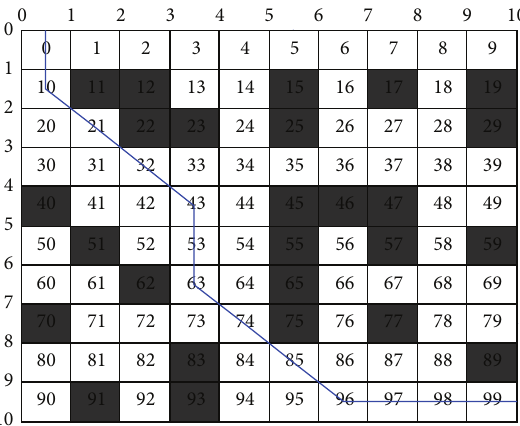
Figure 8: Route after reducing turns by